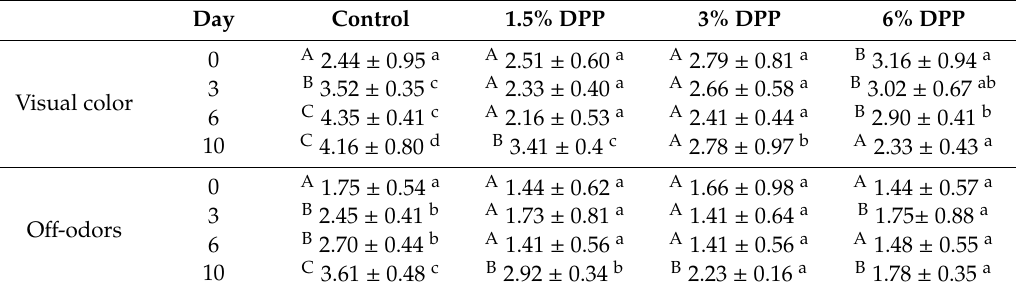
Table 5. Sensory evaluation (trained panel) of burgers with date pit powder (DPP) during refrigerated storage.